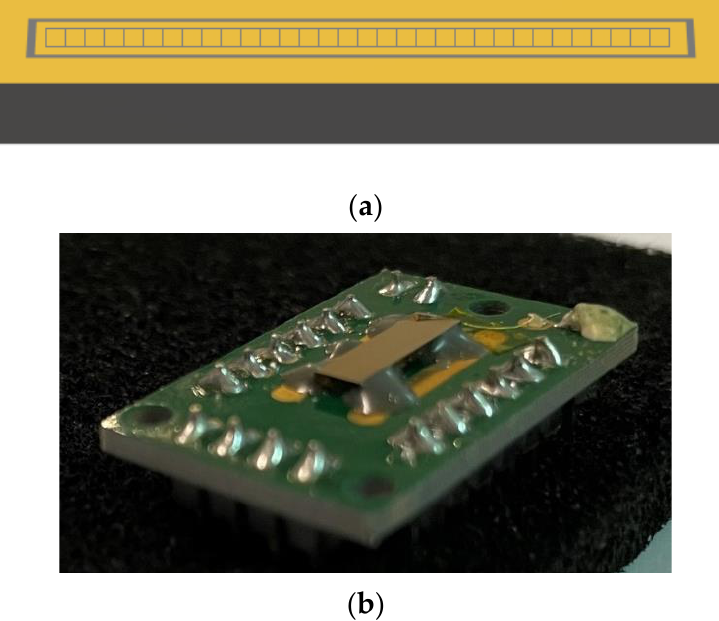
Figure 1. ( a ) The anode layout of the CZT linear array detector (3.0 × 10.4 × 1.1 mm 3 ). The linear array is characterized by 32 pixels (225 µm) with a pitch of 250 µm. The width of the inter-pixel gaps is equal to 25 µm for all pixels. The pixel array is surrounded by internal and external guard-rings. ( b ) A picture of the detector from the cathode